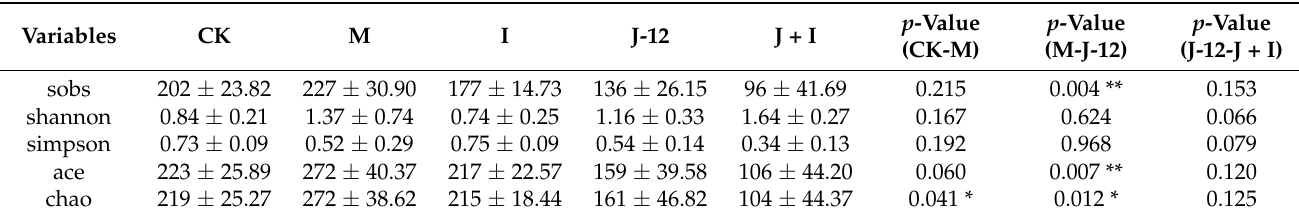
Table 4. The alpha diversity of placental microbiota in rats with hyperglycemia in pregnancy at the genus